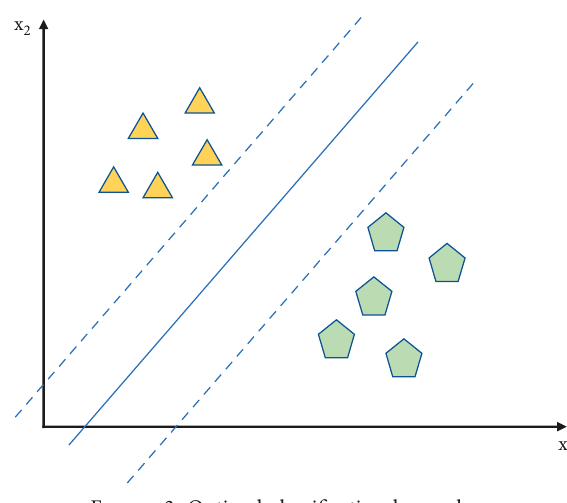
Figure 3: Optimal classification hyperplane.